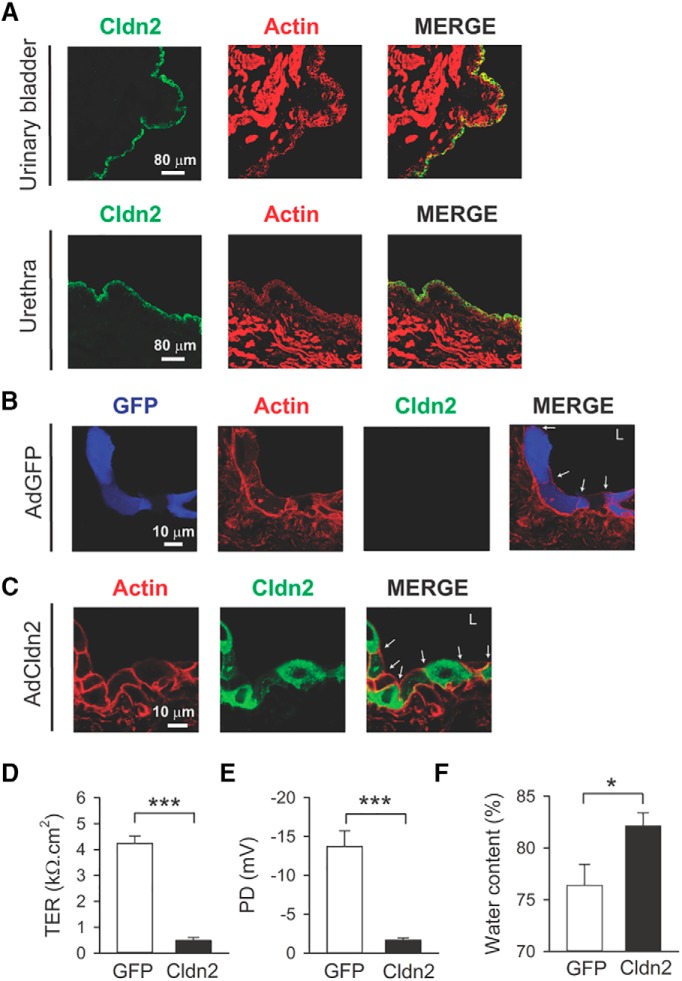

Overexpression of Cldn2 in the bladder urothelium induces cystitis. A, Cross-sections of urinary bladder and urethra harvested from rats transduced with AdCldn2, fixed with paraformaldehyde, and stained with an antibody against Cldn2 (green) and Rhodamine Phalloidin (red). Note that the expression of Cldn2 is restricted to the umbrella cell layer in the urinary bladder and to the epithelium in the urethra. B, C, Cross-sections of bladders transduced with AdGFP (A) or AdCldn2 (B), fixed with paraformaldehyde, and stained with an antibody against Cldn2 (green) and Phalloidin Alexa Fluor 647 for actin (red). Arrows indicate TJs and L indicates lumen. D, E, Tissue electrical resistance (TER) and tissue electrical potential difference (PD) for urinary bladders transduced with AdGFP or AdCldn2. Urinary bladders from transduced rats were mounted in Ussing chambers and the electrical properties were measured as indicated in Materials and Methods. Statistically significant differences between experimental conditions are indicated as ***p < 0.001 (n = 6–9, Mann-Whitney nonparametric test). F, Tissue water content of urinary bladders transduced with AdGFP or AdCldn2. A statistically significant difference between experimental conditions is indicated as *p < 0.05 (n = 6, Mann-Whitney nonparametric test).